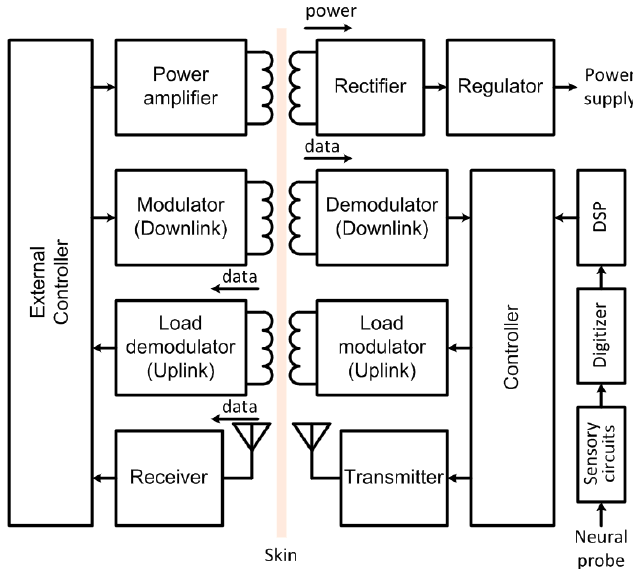
Figure 6. Block diagram of an implantable neural recording microsystem and its multi-carrier wireless